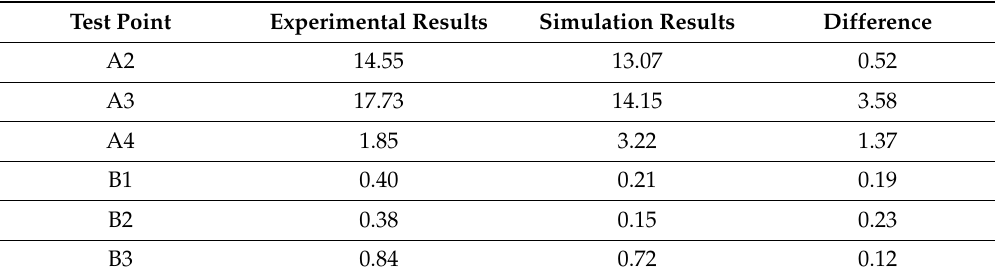
Table 10. Experimental results are compared with simulation results (A/m).